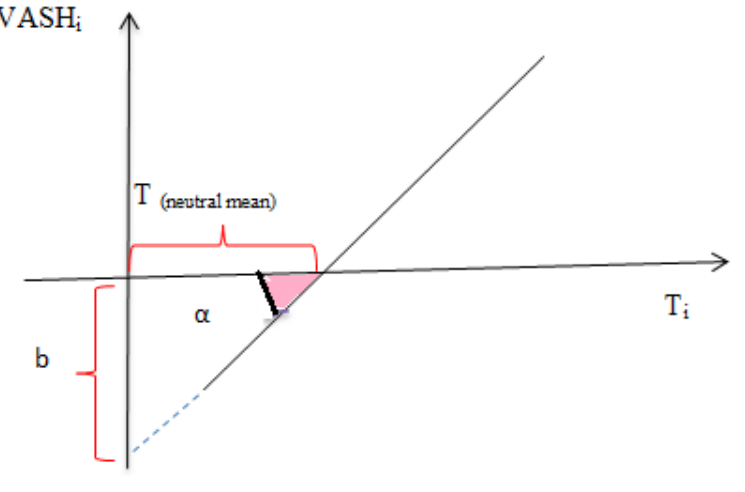
Figure 6. Typical thermal comfort